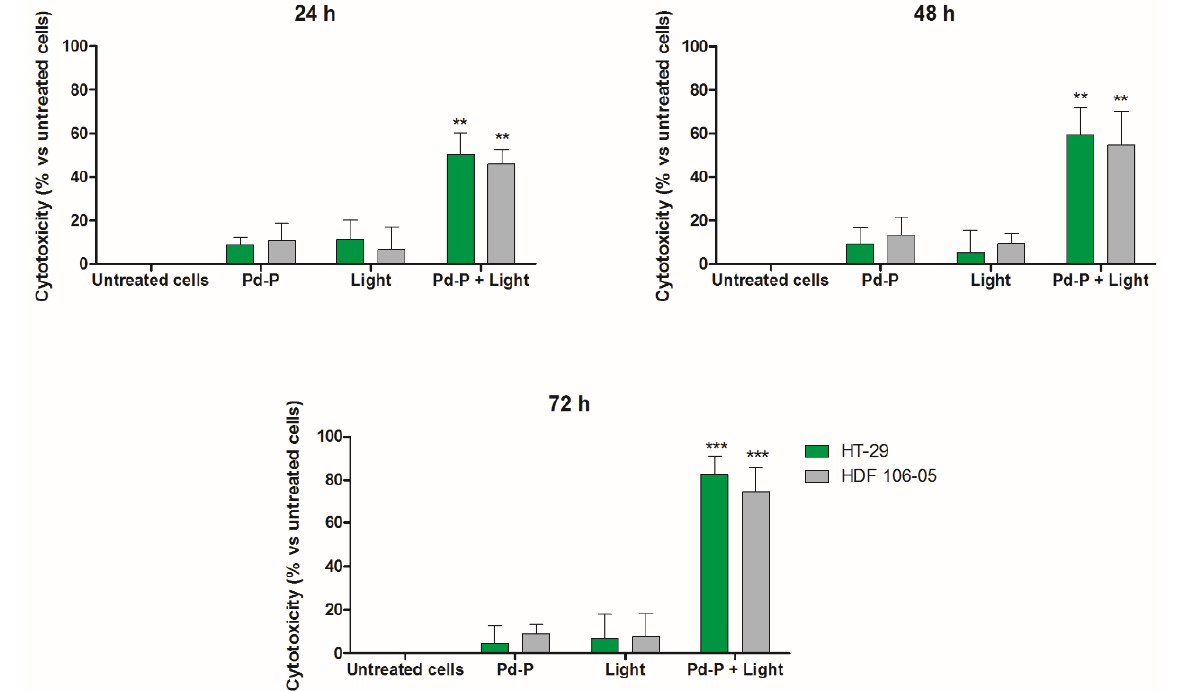
Figure 5. Effect of photodynamic treatment on HT-29/HDF 106-05 co-culture. HT-29 and HDF 106-05 cells, in a 1:1 co-culture, were incubated for 24 h with Pd-P (500 µ M), and then exposed to light (15 mW/cm 2 at 405 nm, for 5 min) at the appropriate wavelength (405 nm). Cytotoxicity was then evaluated after 24, 48 and 72 h by counting HT-29 and HDF 106-05 cells. Data are expressed as percentage of cytotoxic treated cells versus untreated condition. Statistically significant difference versus untreated cells: ** p < 0.01, *** p < 0.001.